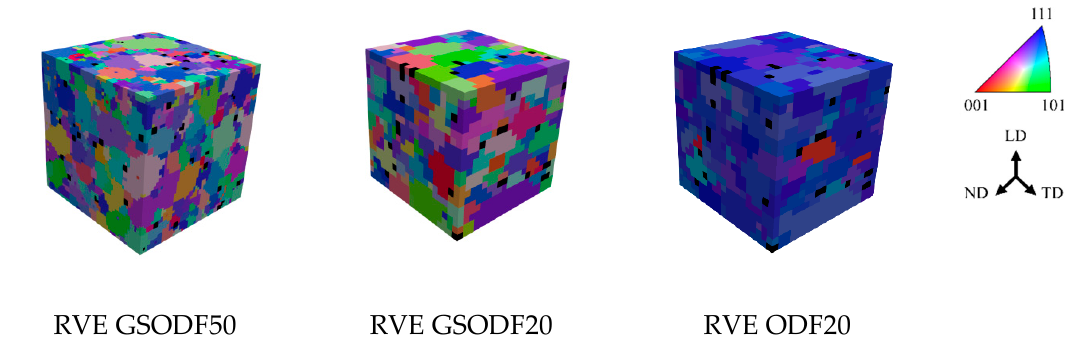
Figure 4. IPF maps in the ND direction of the three generated Representative Volume Elements (RVEs).